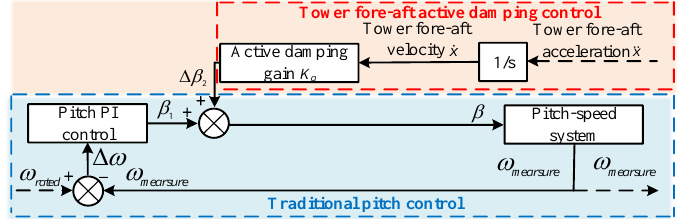
Figure 1. The principle of novel pitch control.